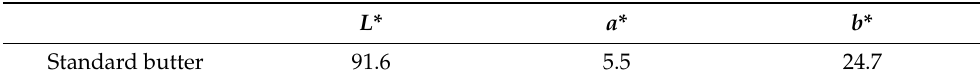
Table 3. The standard table for comparing the test samples was taken from the publication of Chudy et al. [35]. L